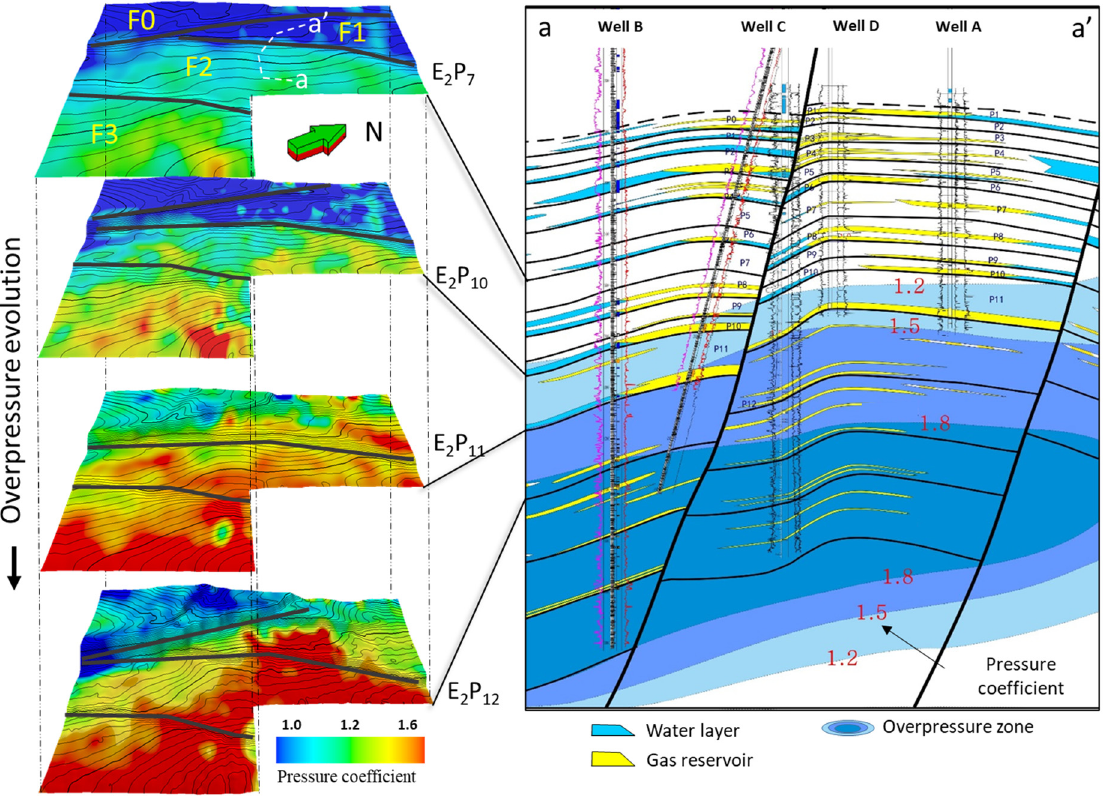
Figure 14. Relation between overpressure and hydrocarbon accumulation.